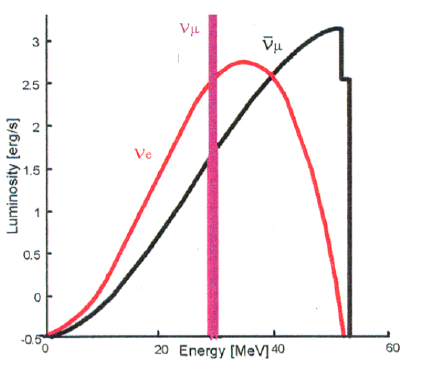
Energy spectra for neutrinos from p + and m +